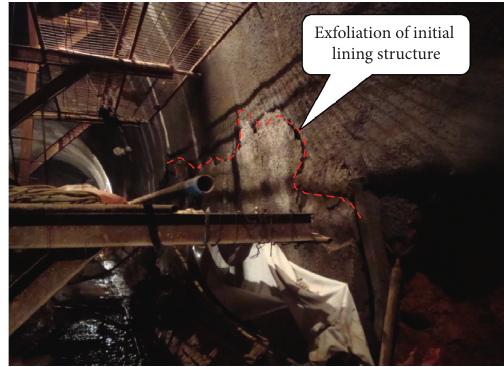
Figure 11: Exfoliation of the preliminary lining structure.